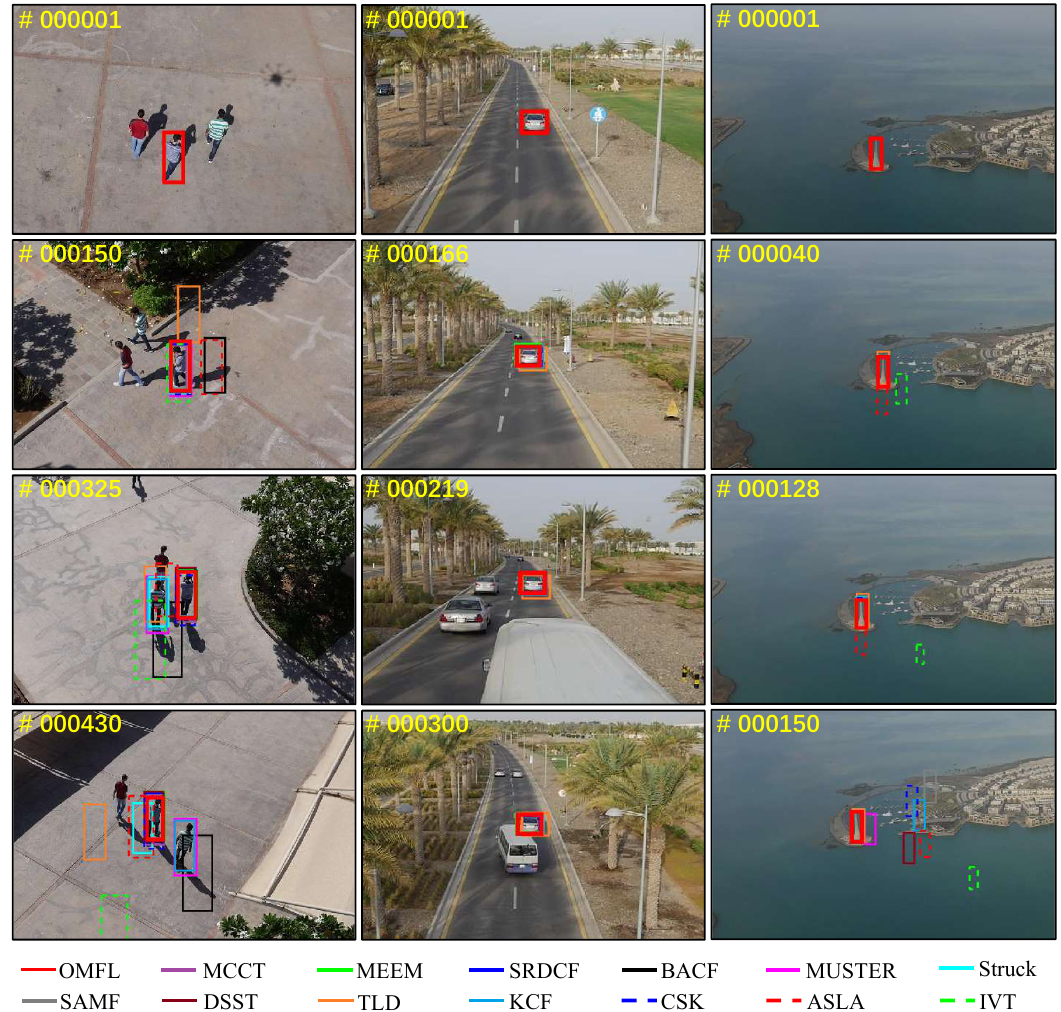
Figure 13. Examples of unmanned aerial vehicle (UAV) tracking results. The first, second, third columns show the group1_1, car10, building5 image sequences. Code and UAV tracking video are: https://github.com/vision4robotics/OMFL-Tracker and https://youtu.be/9XWjrD2i0Y0. Figures 14 and 15 provide the precision and success plots on different